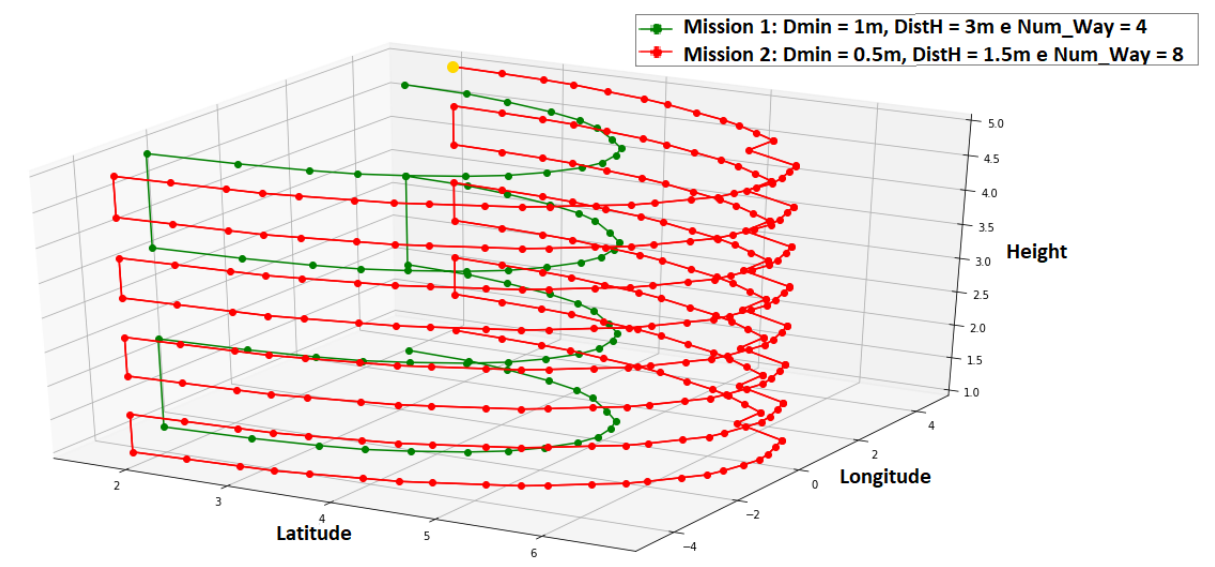
Figure 8. Mission example.